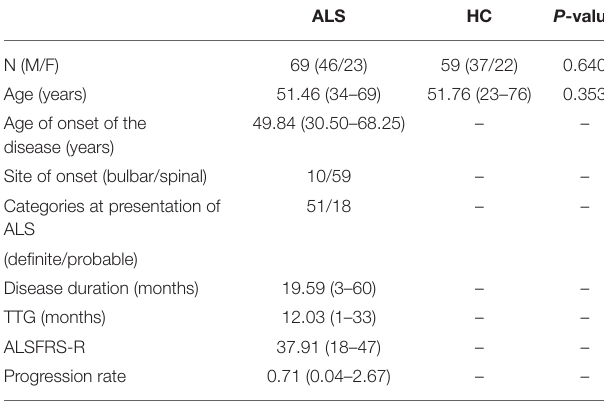
TABLE 1 | Clinical characteristics of the